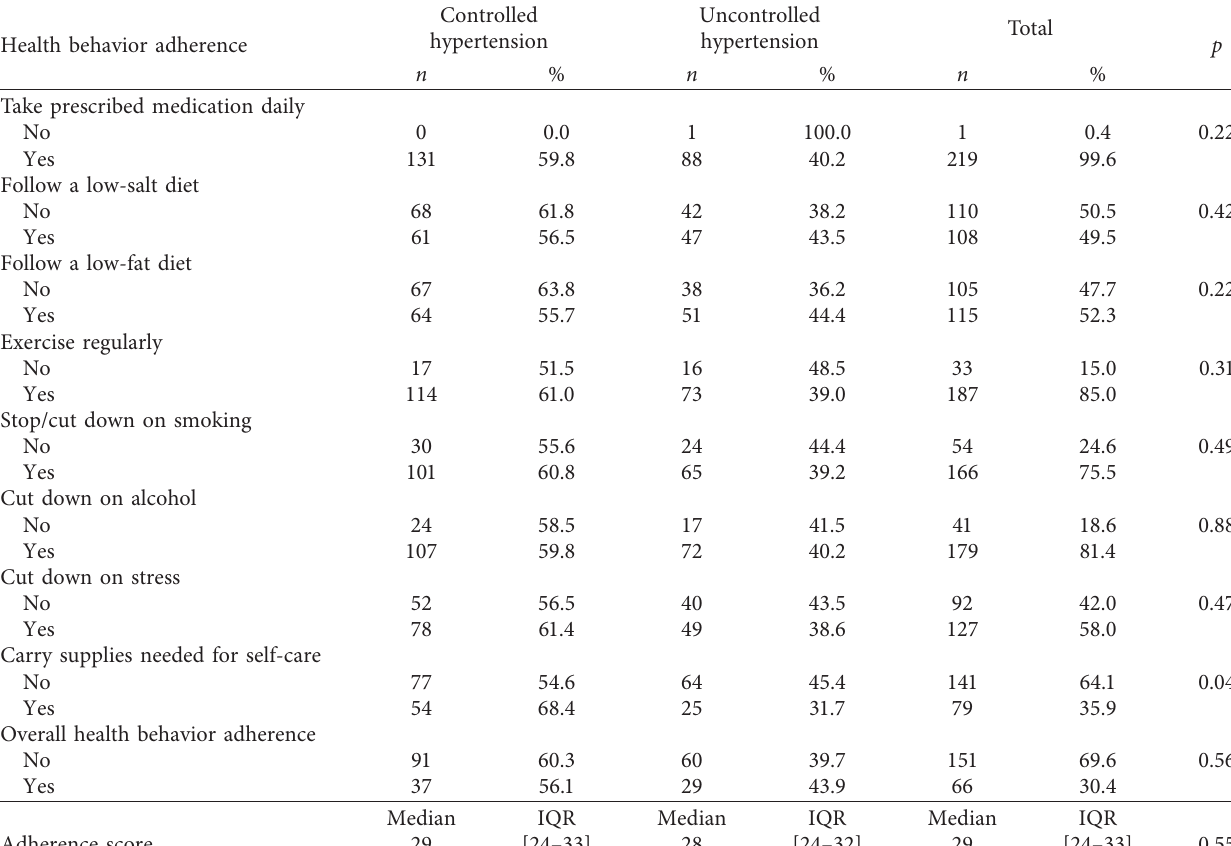
Table 3: Health behavior adherence of hypertensive patients.